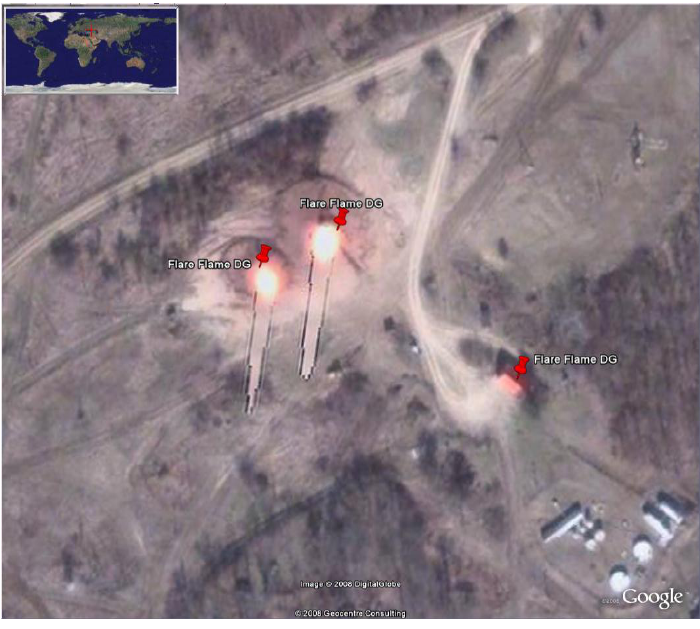
Figure 7. The identification of three flames at a gas flaring location using the high resolution base imagery available in Google Earth. Each of the DMSP identified gas flare locations were inspected in Google Earth for visual confirmation of the feature and to eliminate the inclusion of human settlements and features such as airports from the final set of gas flare features. A total of 2,500 gas flaring features were identified using Google